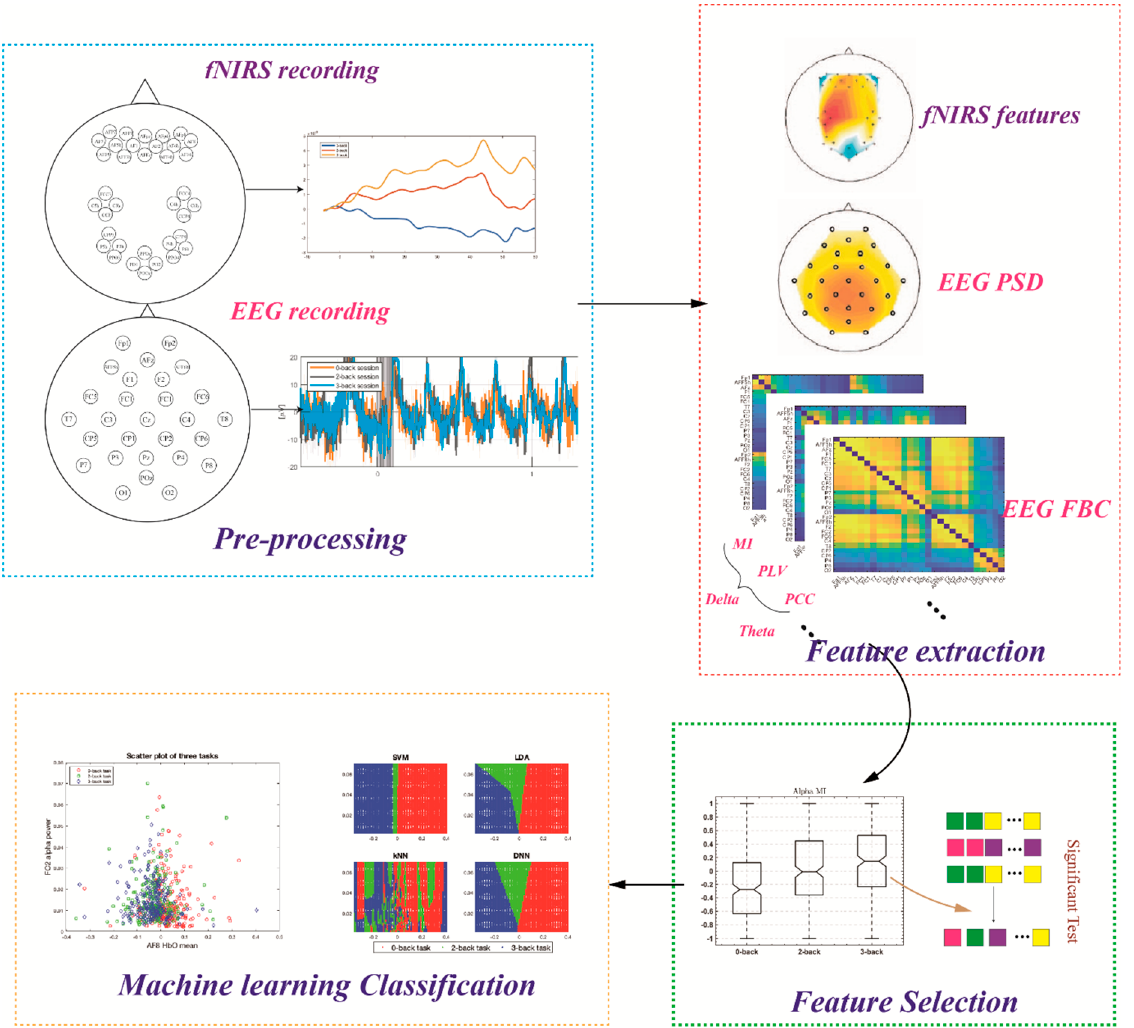
Figure 1. Flowchart of the proposed framework. The pipeline contains four main steps: pre ‐ processing, feature extraction, feature selection and machine ‐ learning classification.